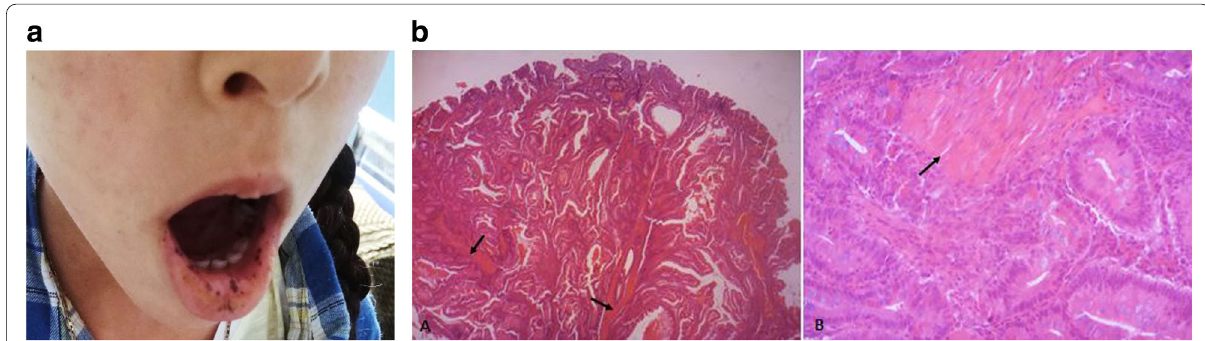
Fig. 3 a Dark mucocutaneous pigmentation observed over the lips of the child. b Histology image of jejunal Peutz-Jeghers polyp. A: Polyp with hyperplastic foveolar epithelium and inflammatory stroma with some cords of smooth muscle